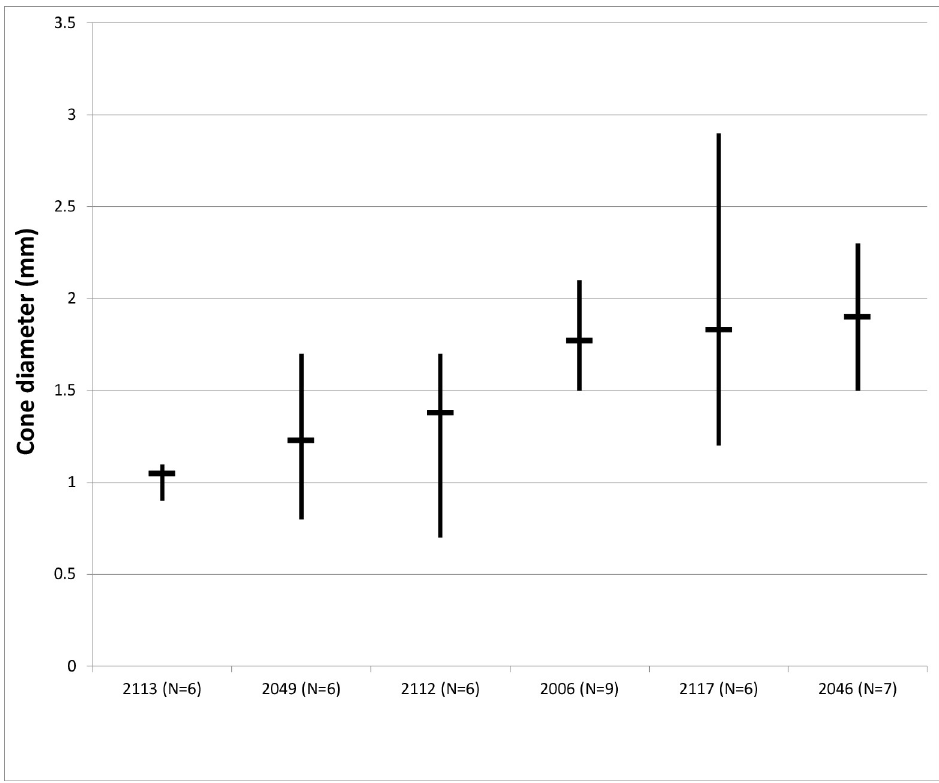
Fig 11. Chart showing the mean and range of incipient cone diameters on six cores, listed by excavation context, Horizon IV, Saruq al-Hadid. https://doi.org/10.1371/journal.pone.0270513.g011 on average than the discarded cores (51.9 ± 16.4 mm, N = 32), and the difference in averages suggest that stone dimensions decreased by 30% through reduction (Fig 12). When the same calculation is done by weight rather than maximum dimension, about 46% of stone mass was lost from the manuport/assayed cobble phase (56.7 ± 38.9 g, N = 32) to the cores discarded into the deposits (30.9 ± 20.8 g, N = 94). Extrapolating to the flake assemblage, the chert/chal- cedony core reduction flakes in context 1309 (N = 217) weigh 423 g in total, and in context 2009 the core reduction flakes (N = 166) weigh 249 g in total. Using the 46% attrition inferred above, these weights suggest the reduction of 16 cores in context 1309 and 10 cores in context 2009; the actual number of discarded cores in these contexts was 8 and 6 respectively, about half the predicted number in both cases. These calculations should be interpreted cautiously because the standard deviations on the metrics are relatively large, and using average dimen- sions masks this variability. The calculations also assume that the manuports and assayed Table 2. Number of platforms on cores, all contexts, Horizon IV, Saruq al-Hadid. Core type Number of platforms Total Single platform 28 Multiplatform -- Bifacial centripetal